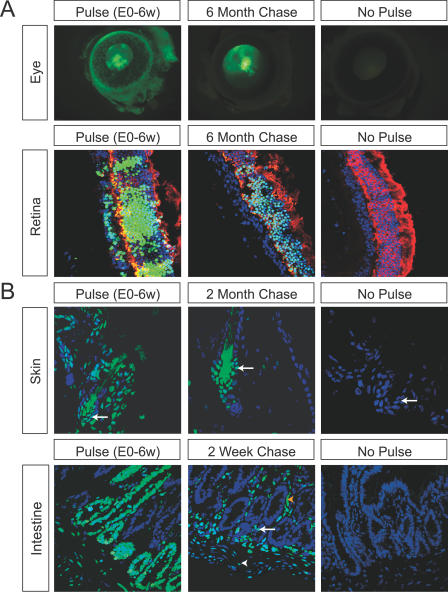
Identification of LRCs in Postmitotic Cells and Stem Cell Populations Indicates Stability of H2BGFP Fluorescence(A) LRCs detected in the postmitotic photoreceptor cells of the retina after expression of Rosa26-rtTA; tetO-H2BGFP from E0–E6 wk. Top row: H2BGFP fluorescence in the eye persists at least 6 mo following initial pulse. Original magnification, 20×. Bottom row: label retention in the retina is restricted to postmitotic photoreceptor cells, labeled in red with anti-recoverin. Original magnification, 400×. All images are exposure matched.(B) LRCs detected in the adult skin and intestine after expression of Rosa26-rtTA; tetO-H2BGFP from E0–E6 wk. In the skin, bulge stem cells are labeled with an arrow. In the intestine, a putative crypt cell is marked with an arrow. White arrowheads mark smooth muscle, and yellow arrowheads label enteric neurons. Images are exposure matched. Original magnification: skin, 630×; intestine, 400×.